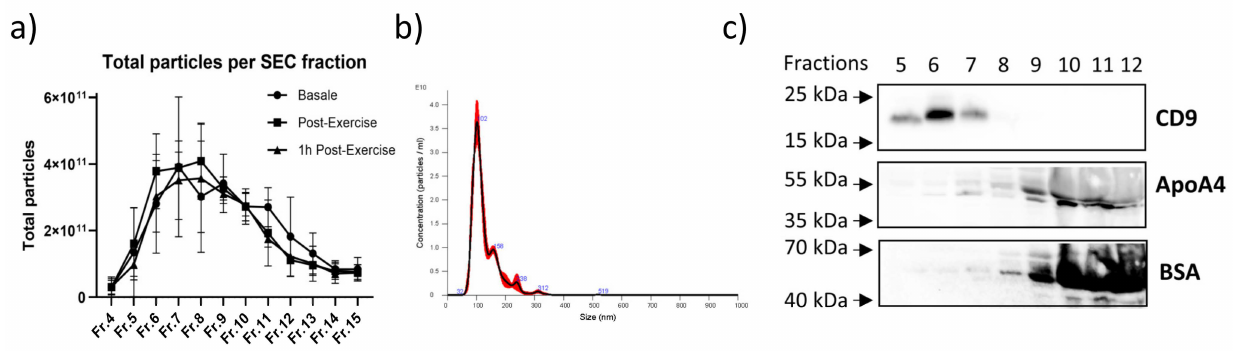
Figure 7. Size exclusion chromatography separation of EVs from plasma at baseline, Post-Exercise and 1 h Post-Exercise ( a ). NTA size distribution plot of EVs collected from Fr. 7 ( b ). Western blot analysis of Fr. 5–Fr. 12 using antibodies against CD9, ApoA4 and BSA ( c